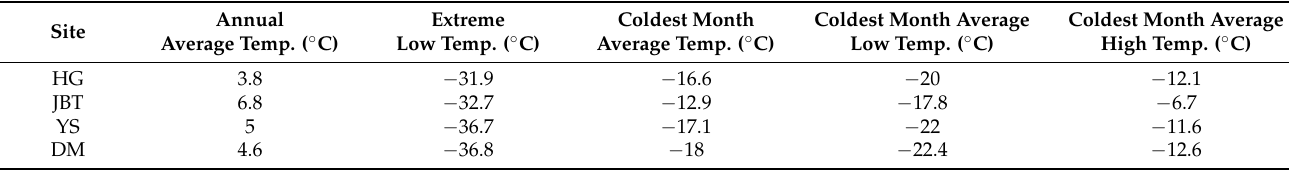
Figure 1. Sampling sites for Sirex noctilio in China showing the geographic range of the species by province. The inset map shows the location in the northeast of China. Table 1. Specific temperatures of sampling sites. HG denotes Hegang City, Heilongjiang Province. JBT denotes Jinbaotun, Horqin Left Wing Rear Banner, Tongliao City, Inner Mongolia Autonomous Region. YS is Yushu City, Jilin Province. DM denotes Duerbote Mongolian Autonomous County, Daqing City, Heilongjiang